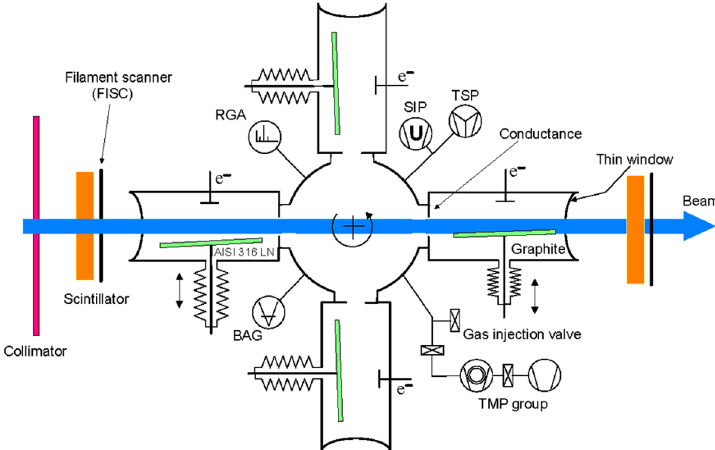
FIG. 1. (Color) Schema of the ion-induced desorption experiment at the CERN